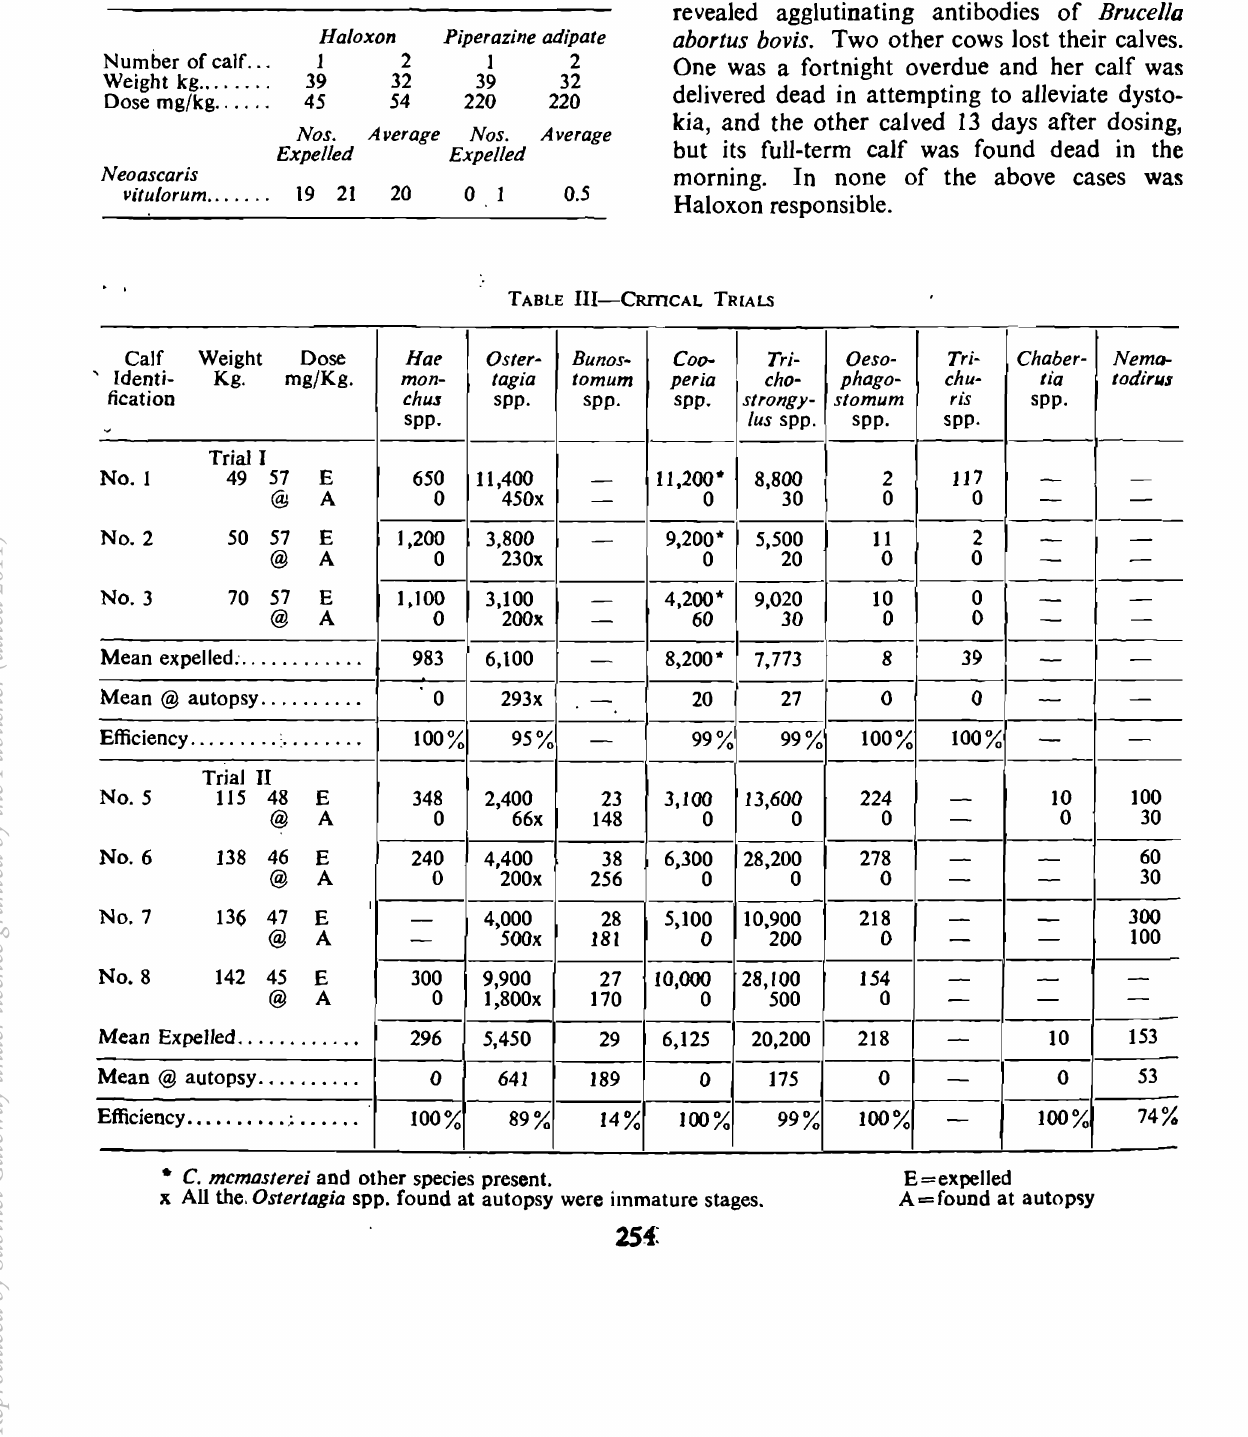
TABLE IV WORMS EXPELLED AFfER DOSING CALVES WITH HAlOXON AND'THEN WITH Piperazine adipate AT 220 mg/kg.